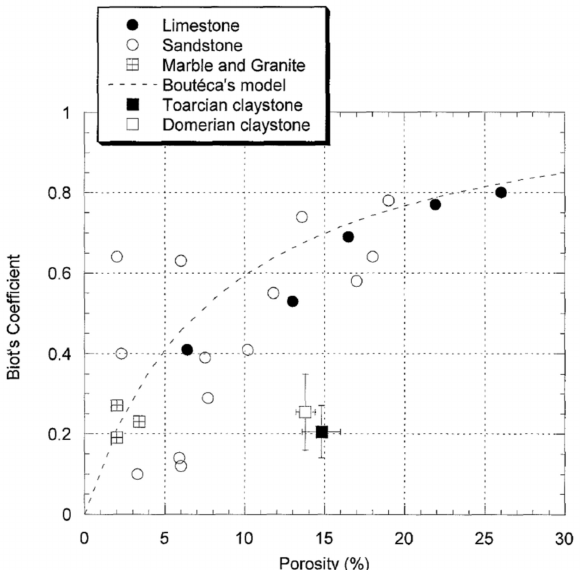
Figure 7. Experimental observation of the relationship of the Biot coefficient to porosity (Cosenza et al. [90]). [Data also attributed to Rice and Cleary [91], Cheng and Detournay [92], Bout é ca and Sarda [93], Charlez [94], and Fabre and Gustkiewicz